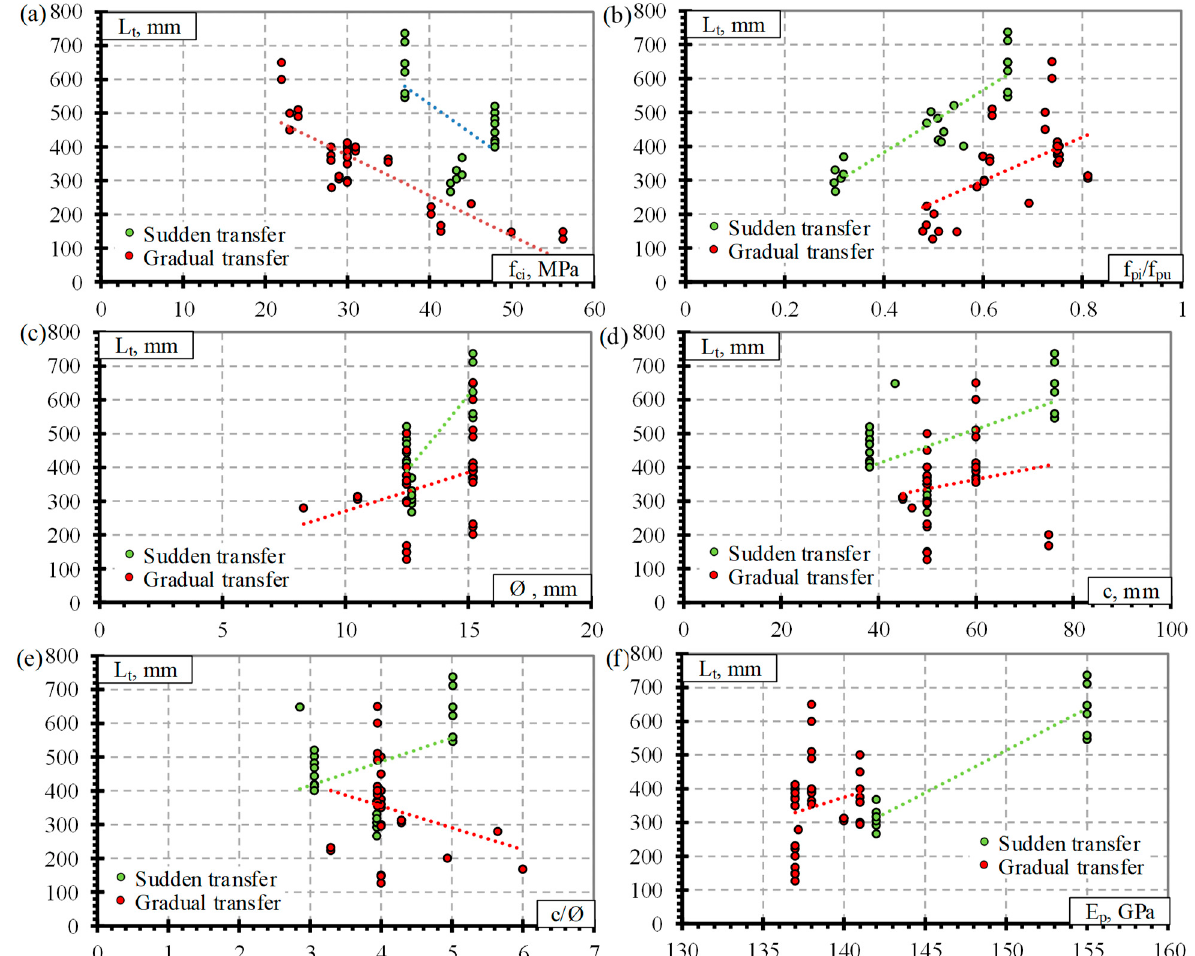
Figure 2. Relationship between transfer length and ( a ) concrete compressive strength at transfer (f ci ), ( b ) ratio between initial stress and tensile strength (f pi /f pu ), ( c ) reinforcement diameter (Ø), ( d ) concrete cover (c), ( e ) ratio between the concrete cover and reinforcement diameter (c/Ø), ( f ) modulus of elasticity (E p ) of different types of CFCC pretensioned reinforcement under different methods of prestress